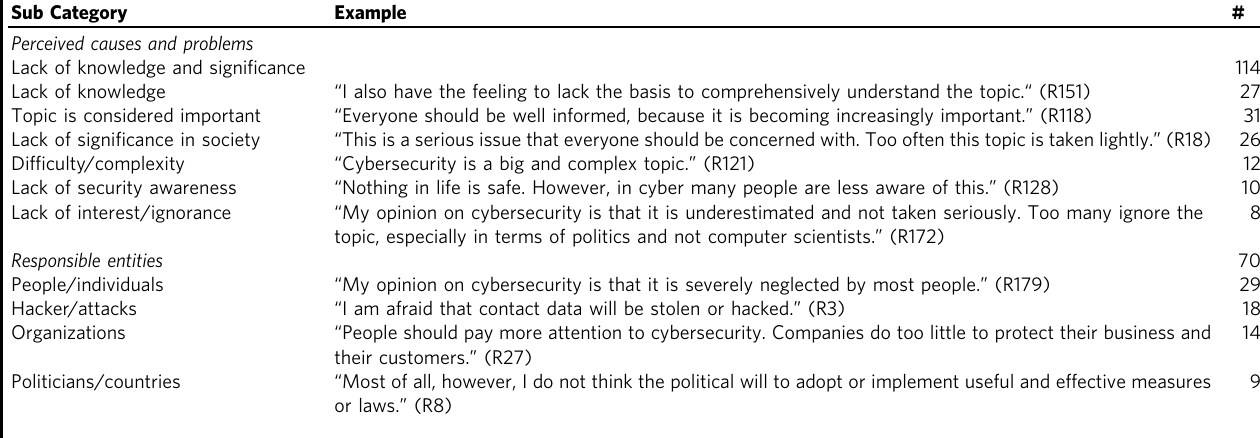
Table 3 Overview of the content-wise categories and examples for codes included in the categories (# = number of